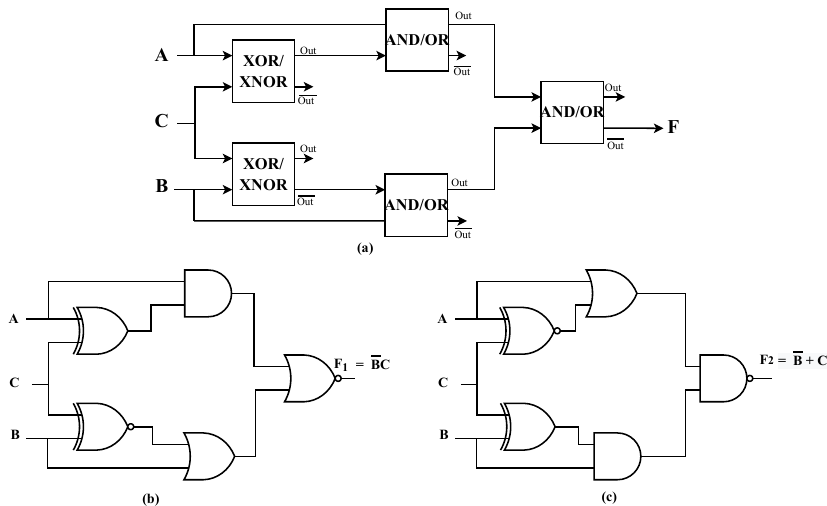
Figure 3. Preventing manufacturing-time tampering using spintronics PG. ( a ) An example circuit (Clk and Ctrl signal are connected to every block). ( b ) Equivalent gate-level diagram with Ctrl = 0. ( c ) Equivalent gate-level diagram with Ctrl = 1.